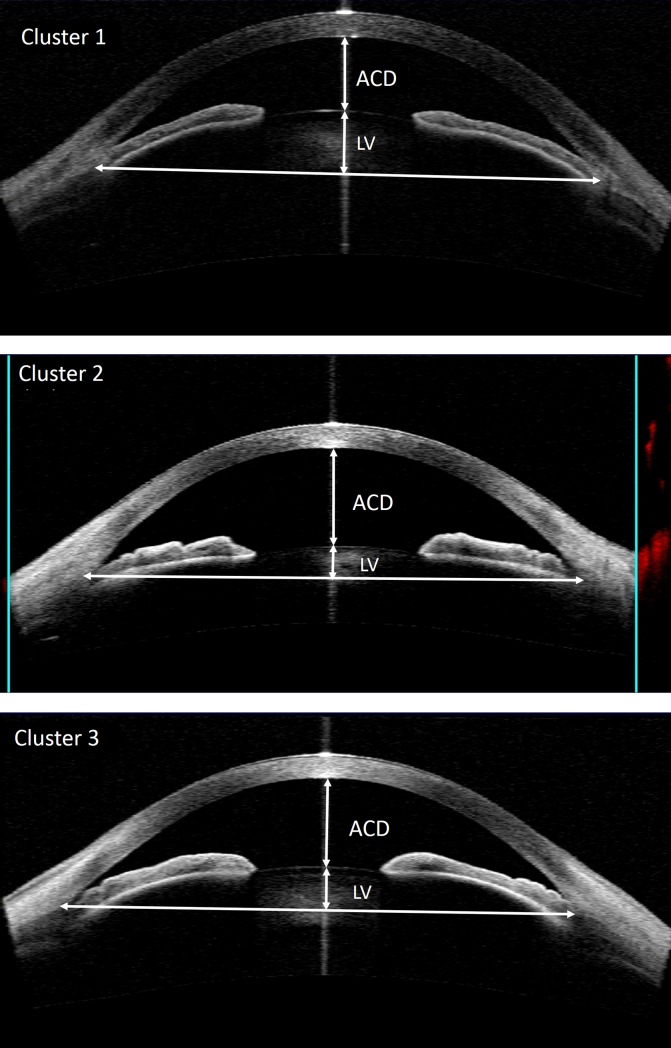
The anterior segment-optical coherence tomography (ASOCT) images of a typical case from each of the 3 clusters: Upper: A case from cluster 1 with shallow ACD and ACA and ACW, and a large lens vault: Middle: A case from cluster 2 with deep anterior chamber and thick iris, bottom: a case from cluster3 with intermediate ACD, ACA, LV, and high iris curvature.